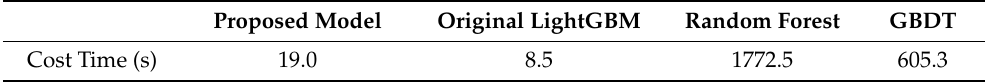
Table 3. Comparison of various correction methods in training time.